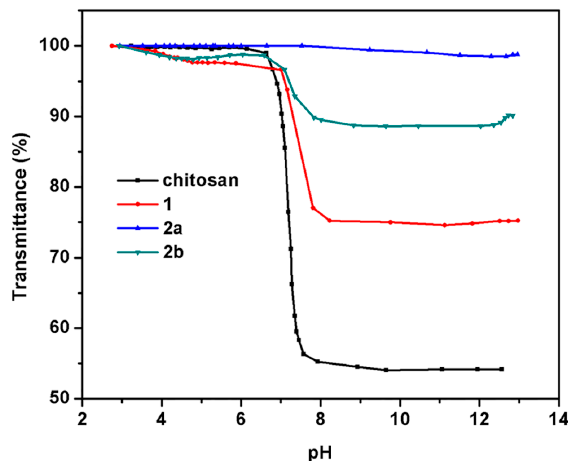
Figure 5. pH dependence of water solubility of chitosan and chitosan derivatives. Table 1. Summary of the solubility properties of chitosan derivatives. Compound